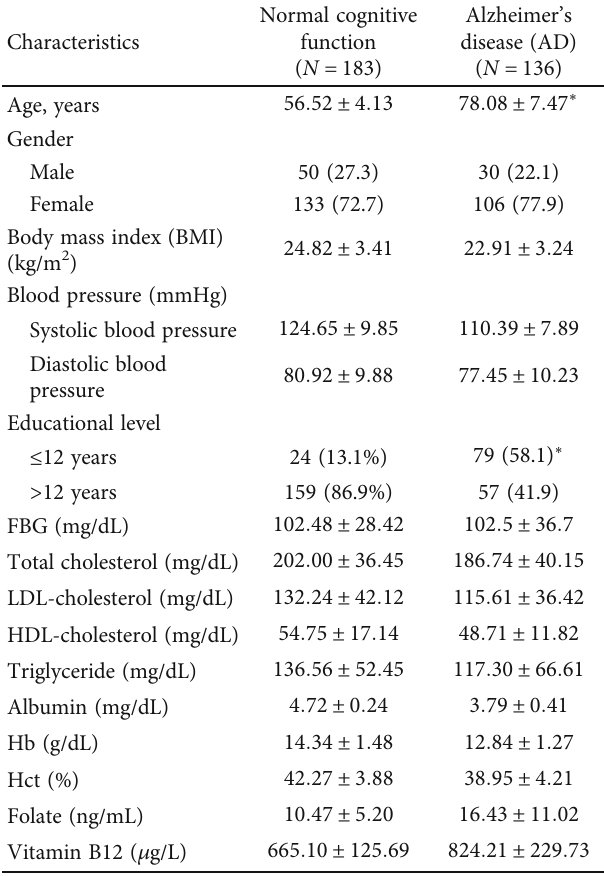
Table 1: Characteristics and clinical parameters of the controls (normal cognitive function) and the AD group.